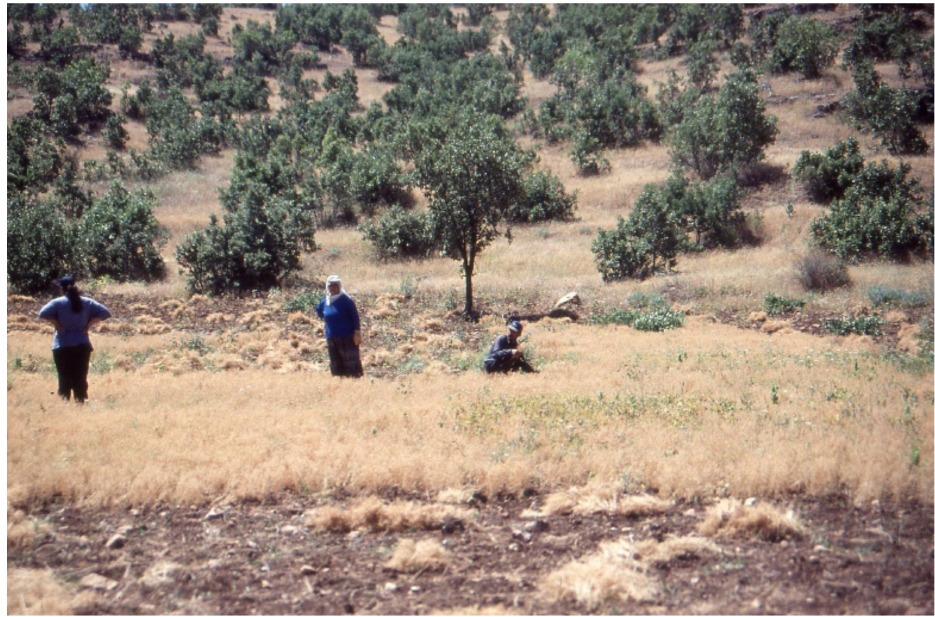
Figure 4. A bitter vetch field during manual harvest (by uprooting) near Midyat, Mardin Province, southeast Turkey, June 2002. A range of weeds can be seen (some still green) within the canopy of the fully mature crop